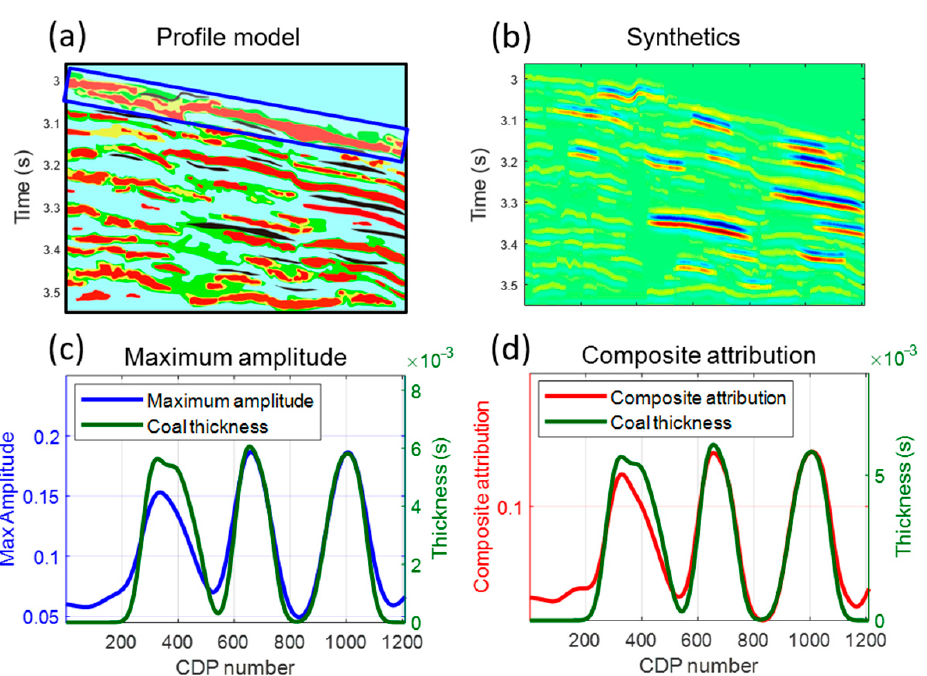
Figure 10. Lateral variable-thickness model comprising sandstone and coal seams: ( a ) Profile model; ( b ) Synthetics; ( c ) Maximum amplitude; ( d ) Composite attribution.